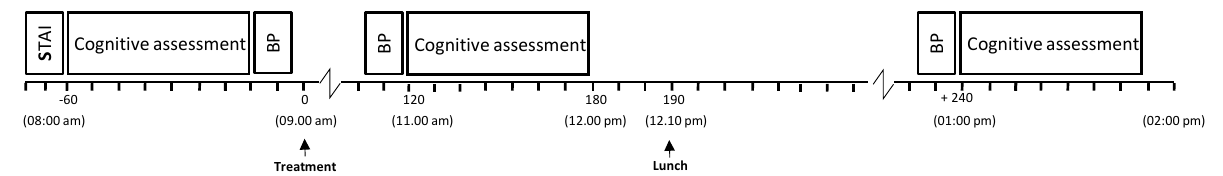
Figure 3. Testing session timeline on both the acute and chronic visits. Participants completed the state subscale of the State Trait Anxiety Inventory (STAI) followed by a full cognitive assessment pre-dose and at 120 and 240 min post-dose. Blood pressure and heart rate were recorded after each cognitive assessment. Lunch was provided at approximately 12:10 p.m.